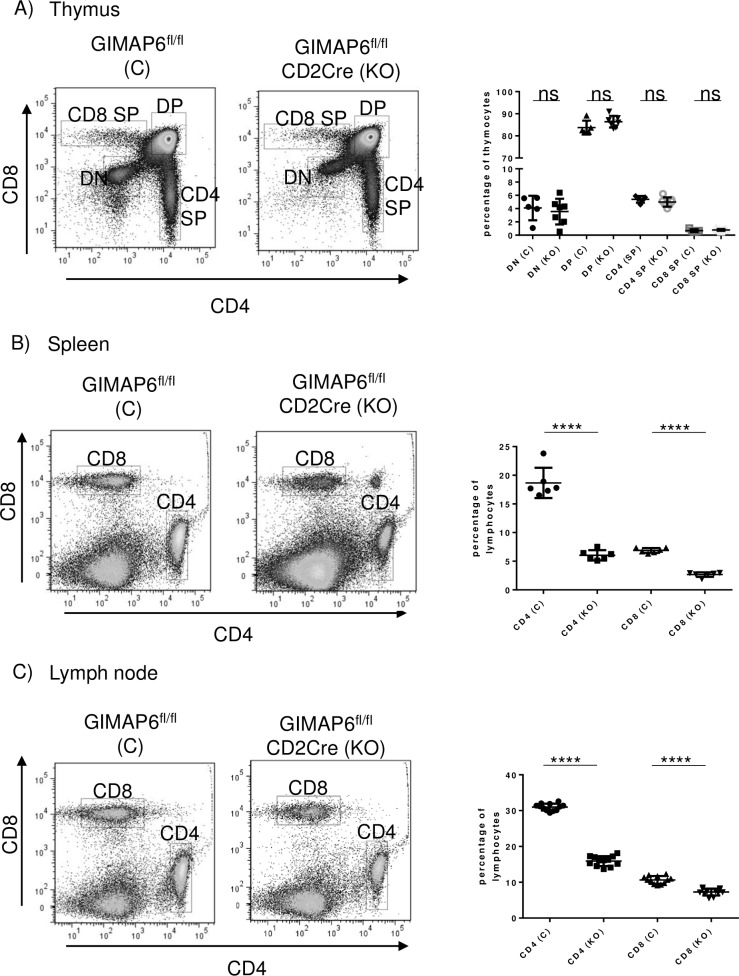
CD4 and CD8 cell analysis in GIMAP6fl/flCD2Cre mice.Total cell suspensions were prepared from thymi, spleens and lymph nodes, were stained for CD4 and CD8 and analysed by flow cytometry. Nucleated cells were gated on the basis of FSC versus SSC, live versus dead and then for CD4 and CD8. Left-hand panels for each tissue show the gated cells. Nomenclature on the plots is: CD4 SP–single-positive CD4 cells; CD8 –single-positive CD8 cells; DP–cells positive for CD4 and CD8; DN–cells negative for both CD4 and CD8; CD4—CD4 cells; CD8 –CD8 cells. In each case, the left-most plot is from GIMAP6fl/fl mice and the right hand plot from GIMAP6fl/flCD2Cre mice. The graphs to the right show the calculated percentage of each cell population. GIMAP6fl/fl mice are indicated by (C) and GIMAP6fl/flCD2Cre by (KO). P values as follows: ns P>0.05; **** P<0.0001. n = 5–7 (unpaired 2-tailed Student’s t test).